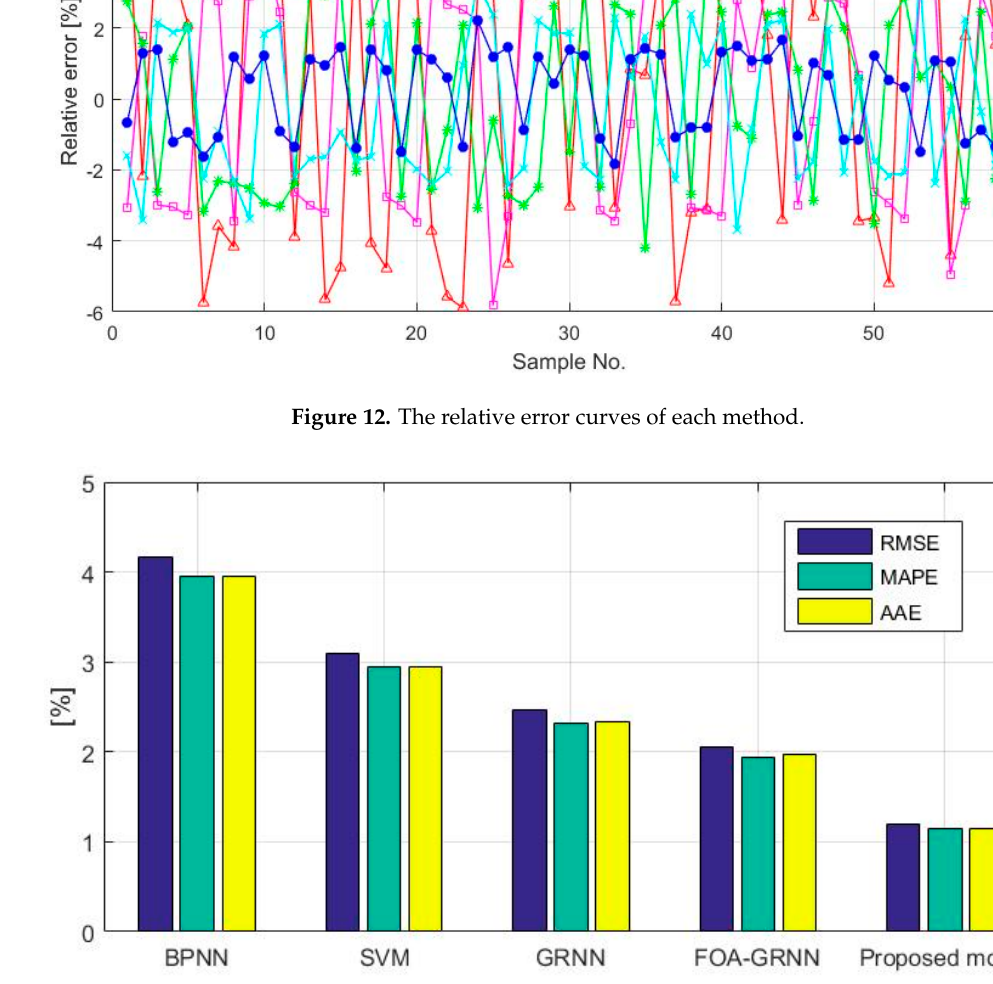
Figure 13. Values of root-mean-square error (RMSE), mean absolute percentage error (MAPE) and average absolute error (AAE).